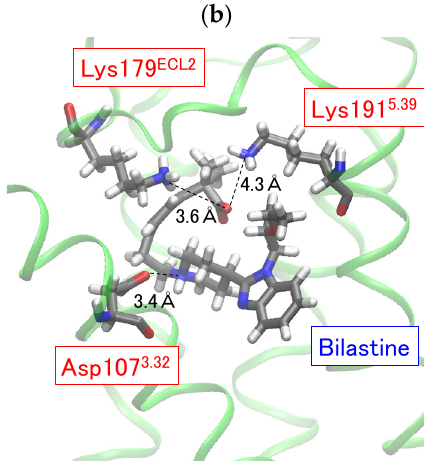
Figure 2. A schematic structure of human H 1 receptor ( a ) and docking simulation on the binding of bilastine to human H 1 receptor ( b ). ( a ) A schematic structure of human H 1 receptor is shown and indicates that Asp107 3.32 is a highly conserved amino acid in the aminergic G-protein-coupled receptors, and Lys179 ECL2 and Lys191 5.39 are anion-binding sites unique to the H 1 receptor. Ligand-receptor interaction is also shown to demonstrate that the binding affinity for ligands ( K d ) is determined by their thermodynamic binding forces ( ∆ G ° = ∆ H ° − T ∆ S ° = RT ln K d). ( b ) Docking simulation was performed to reveal the final position of bilastine binding to human H 1 receptor as described in the materials and methods section. The amino group of bilastine appeared to interact with Asp107 3.32 , and the carboxyl group of bilastine appeared to interact with Lys179 ECL2 and Lys191 5.39 . Atoms of nitrogen, oxygen, carbon, and hydrogen are shown in blue, red, gray, and white, respectively. The distances between key atoms of bilastine and amino acid residues are also shown.